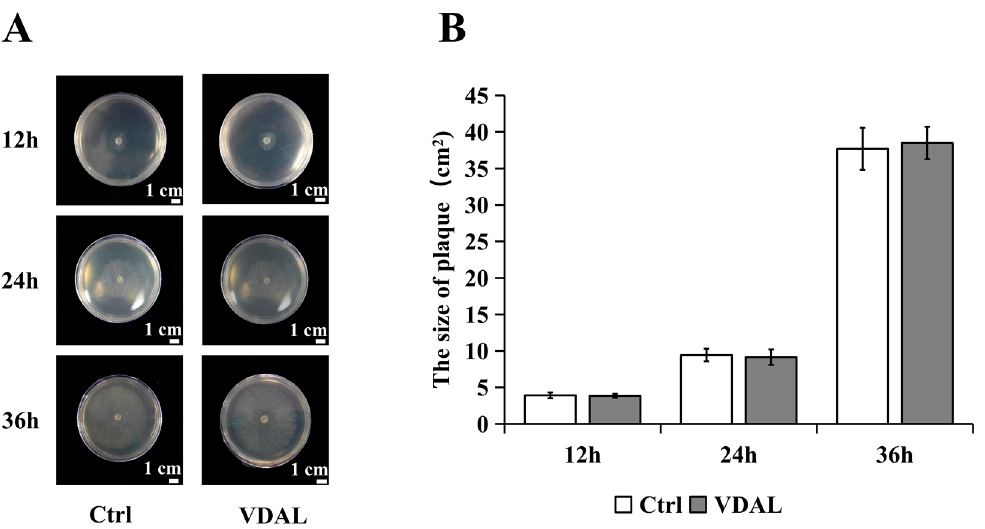
Figure 2. The effect of VDAL itself on S. sclerotiorum . ( A ) The plaque of S. sclerotiorum after being inoculated with water or VDAL on PDA medium after 12 h, 24 h, and 36 h, respectively. ( B ) Histogram of plaque area for S. sclerotiorum on PDA medium after water and VDAL treatment. Five independent replicates were performed. Student’s t ‐ test was used to estimate significant effects.